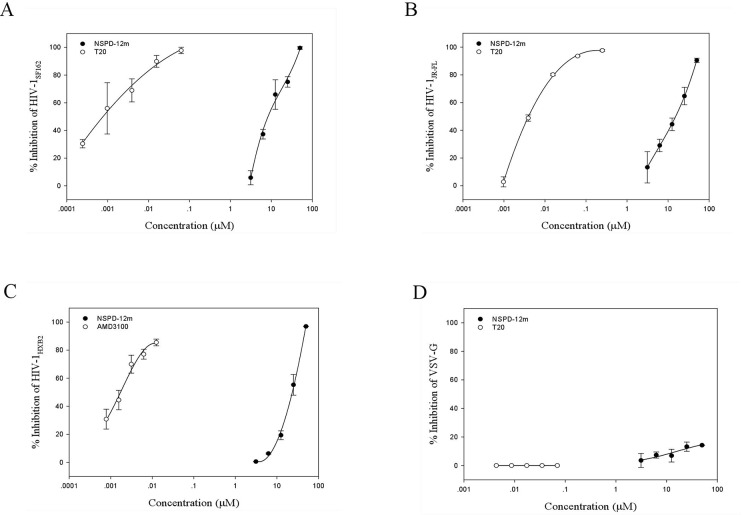
The inhibitory activity of NSPD-12m on infection by HIV-1SF162
(A), HIV-1JR-FL
(B), HIV-1HXB2
(C), and VSV-G (D) pseudotyped virus. The samples were tested in triplicate, and the data were presented in mean ± SD.